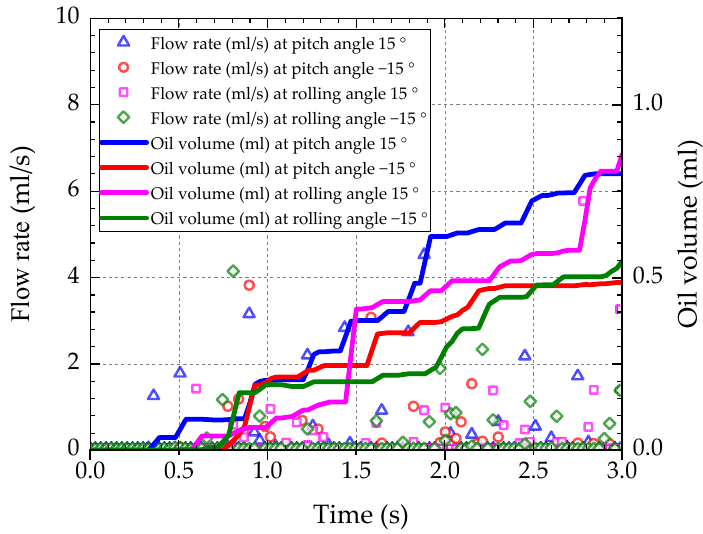
Figure 10. Flow rate–oil volume–time curves (Monitoring Plane 1).